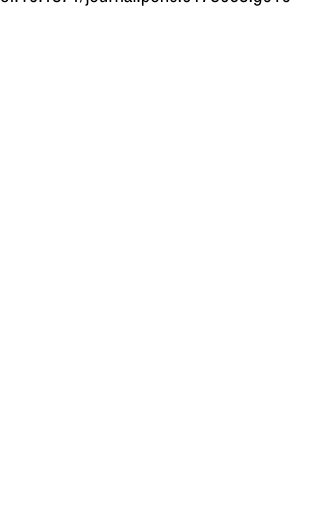
Fig 10. Albatross plot for effect of vouchers for maternity care serviceson births with a skilled birth attendant. MHVS—Maternal Health Voucher Scheme.